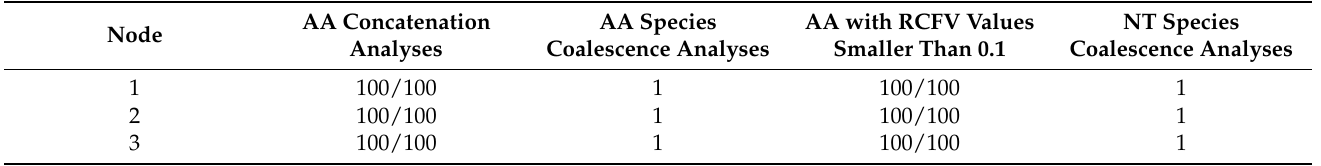
Table 4. Node support values of the finial phylogenetic tree, calculated using SH-aLRT replicates and ultrafast bootstraps. AA Concatenation AA Species AA with RCFV Values NT Species Node Analyses Coalescence Analyses Smaller Than 0.1 Coalescence